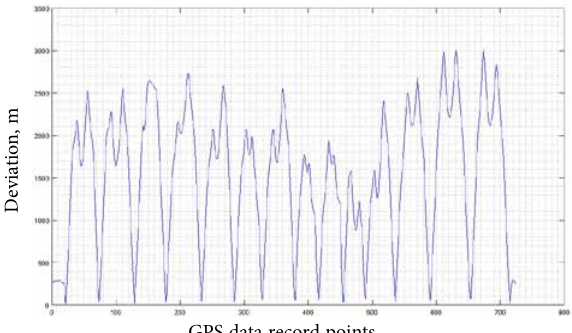
Fig. 13. Diagram of flight distance from runway center